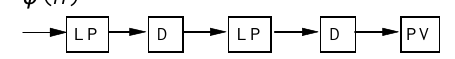
Fig. 4. Block scheme representation of peak value determination. LP – low-pass filter, D – differentiator, PV – peak value detection. of a data sequence. The smoothness of the acceleration sequence allows to apply a simple algorithm comparing successive samples without any approximation